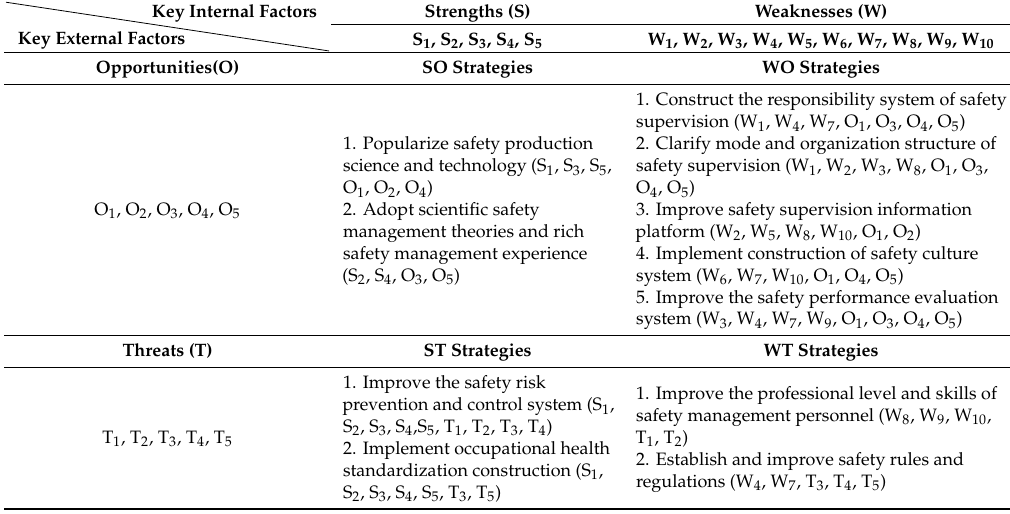
Table 4. Strength-weakness-opportunity-threat (SWOT) matrix